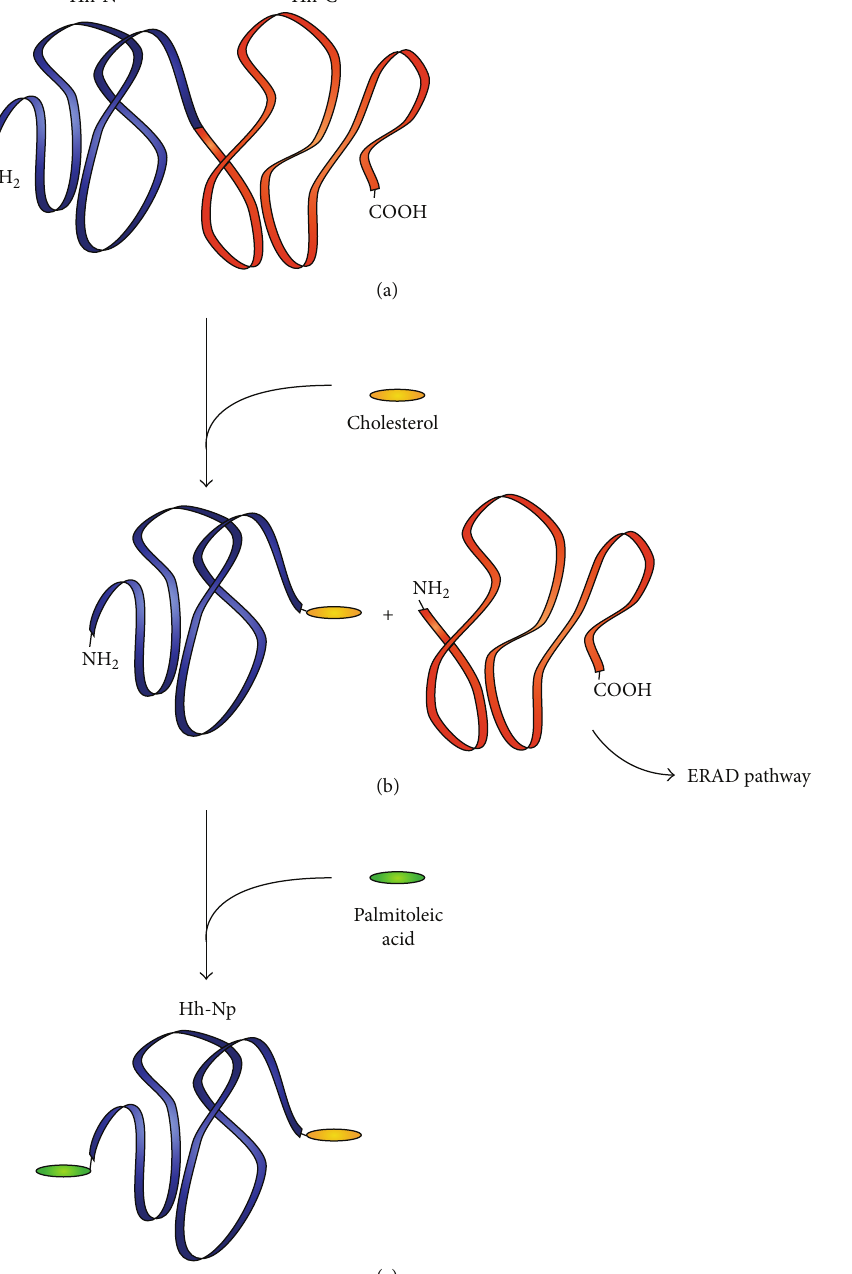
Figure 1: Posttranslational processing of Hh proteins. (a) The unprocessed Hh protein contains a 20 KDa N-terminal fragment (Hh-N) and a 25 KDa C-terminal self-splicing fragment (Hh-C). (b) Autoproteolysis occurs and a cholesterol molecule becomes covalently bound to the C-terminal of Hh-N. Hh-C is later degraded in the ER. (c) Addition of Palmitoleic Acid results in the fully processed form of the protein (Hh-Np) and mediates its transport to the cell